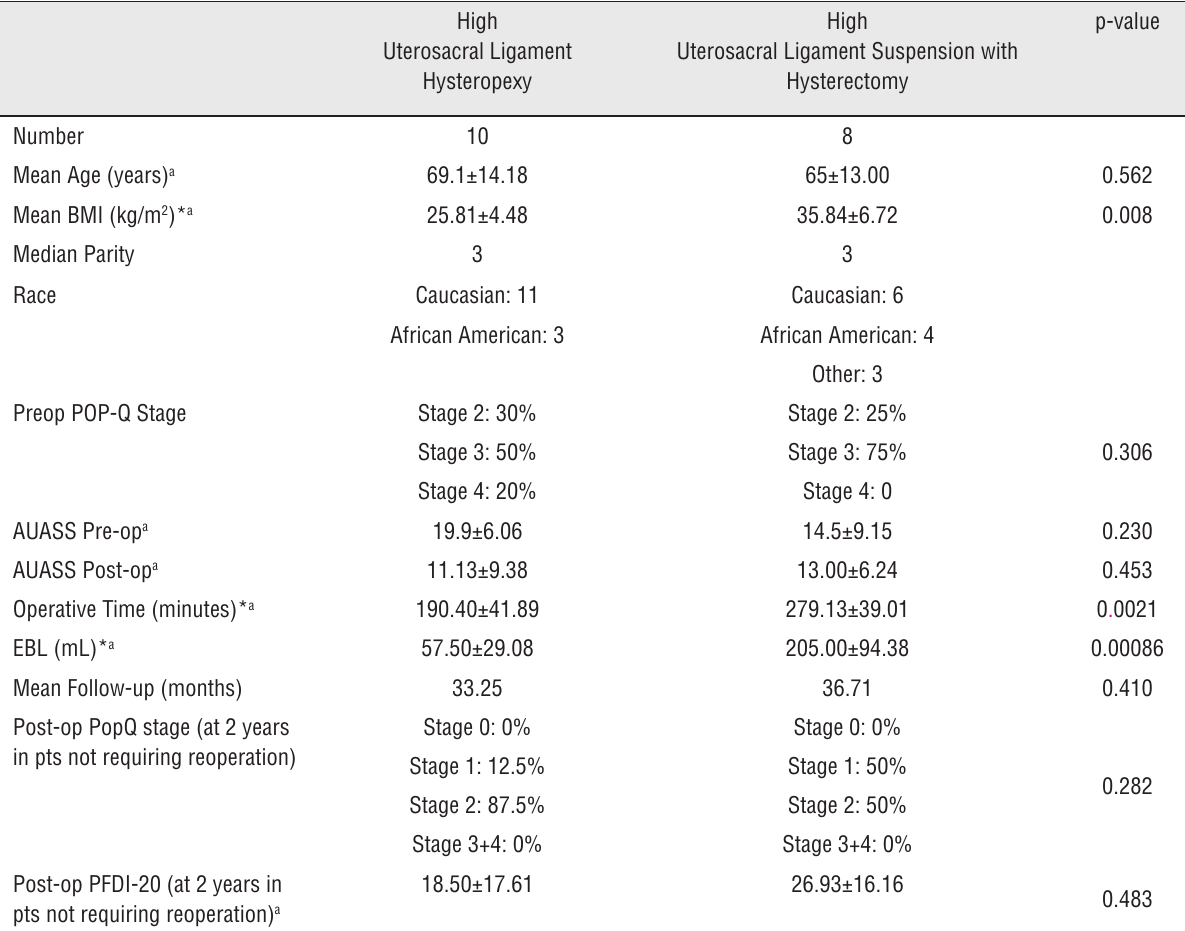
Table 1 - Comparison of outcomes of women undergoing high uterosacral ligament hysteropexy versus hysterectomy and high uterosacral ligament suspension for pelvic organ prolapse repair.